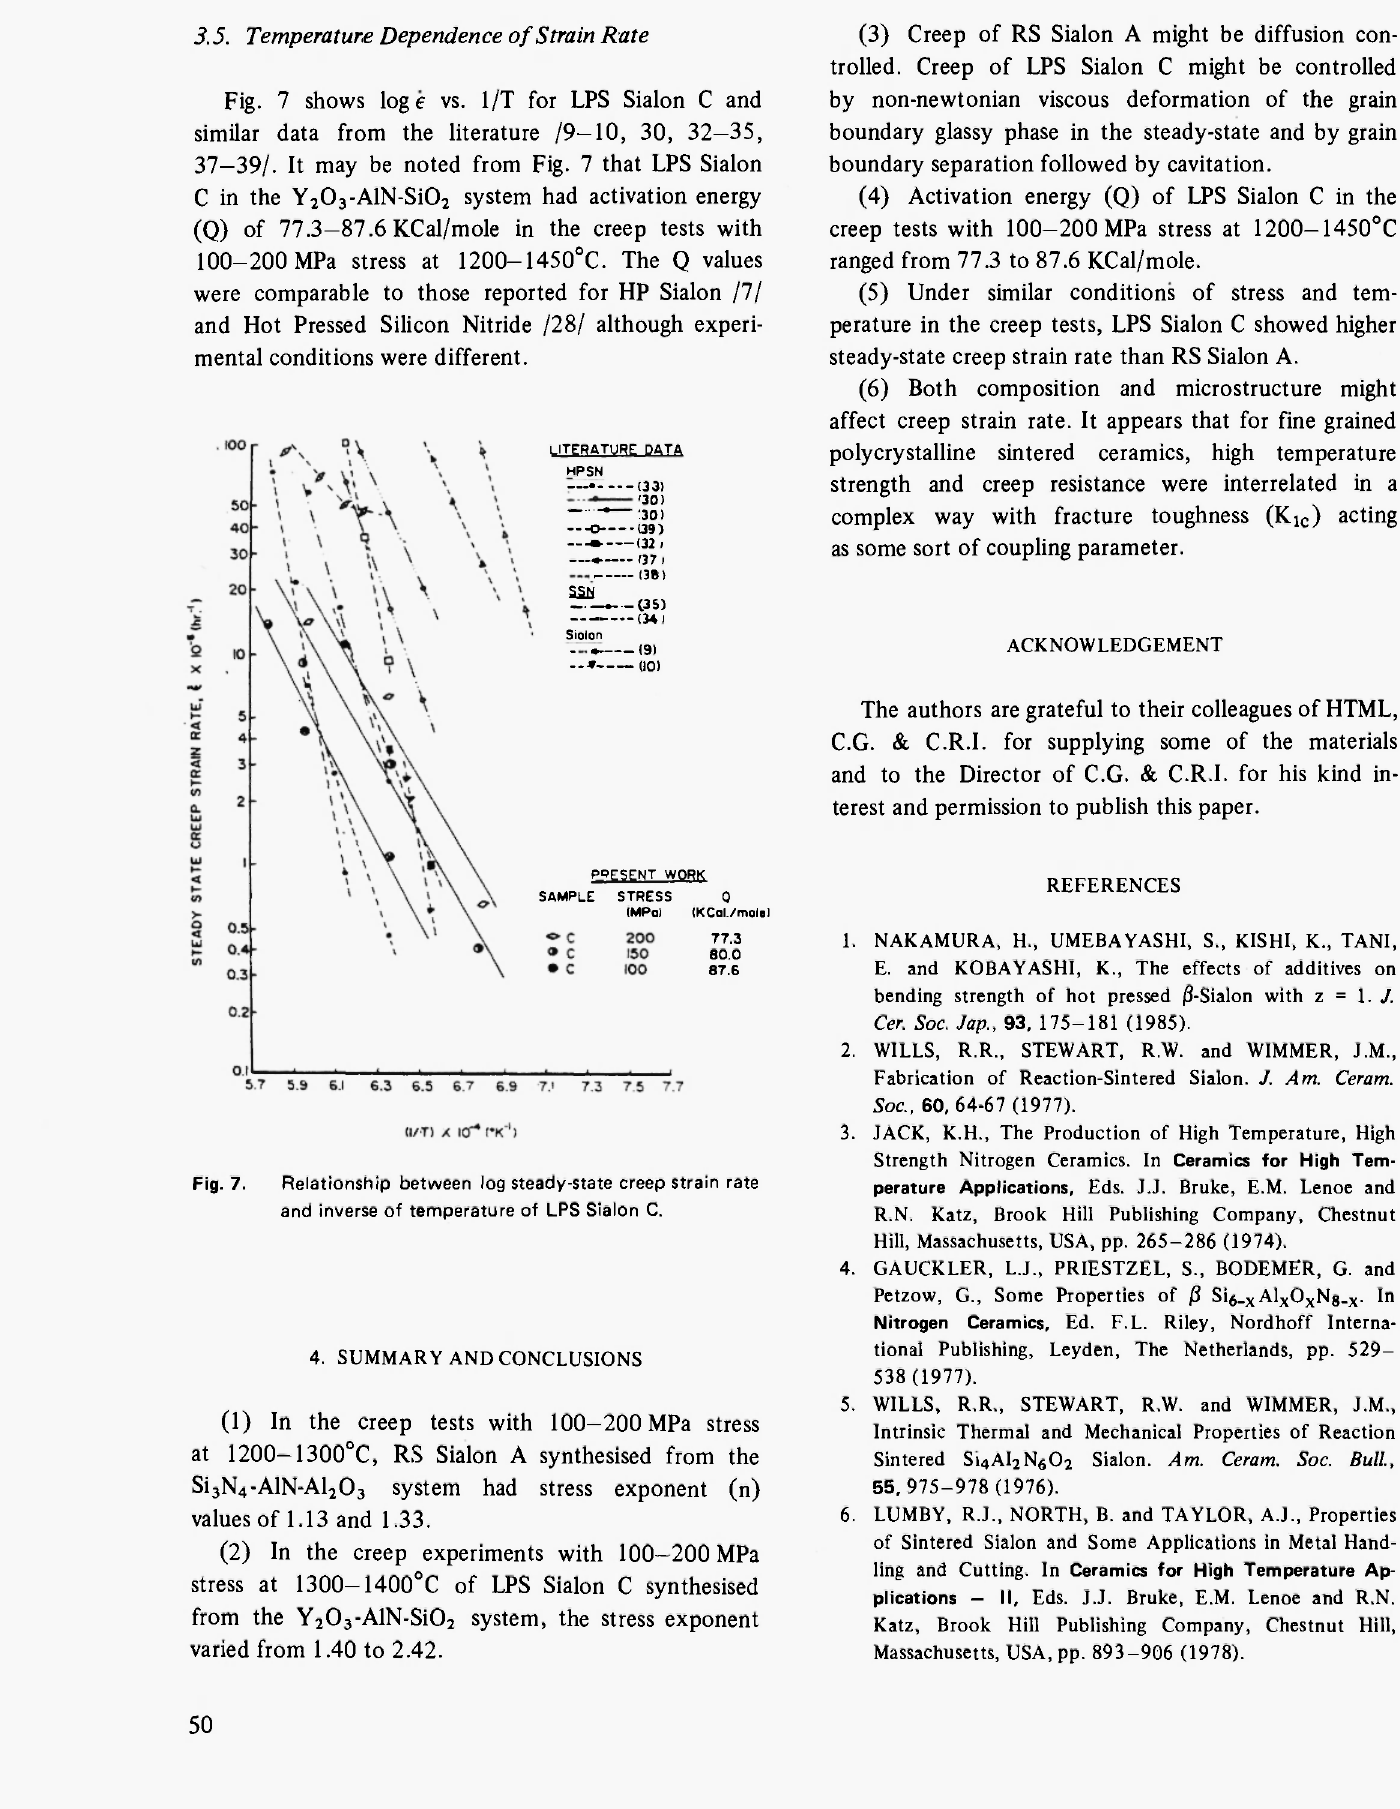
Fig. 7. Relationship between log steady-state creep strain rate and inverse of temperature of LPS Sialon